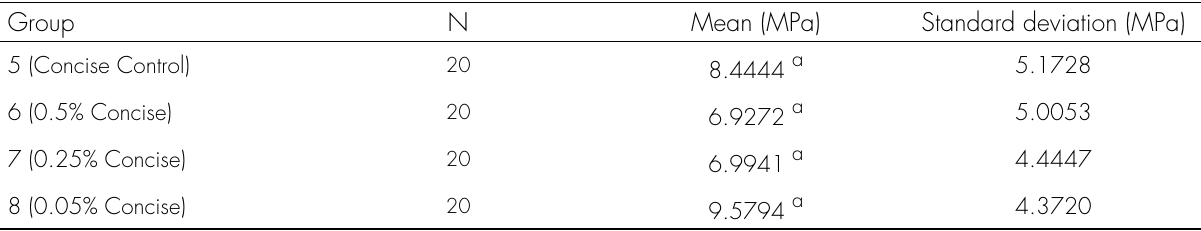
Table II. SBS means and standard deviations of groups 5, 6, 7 and 8 (ANOVA).